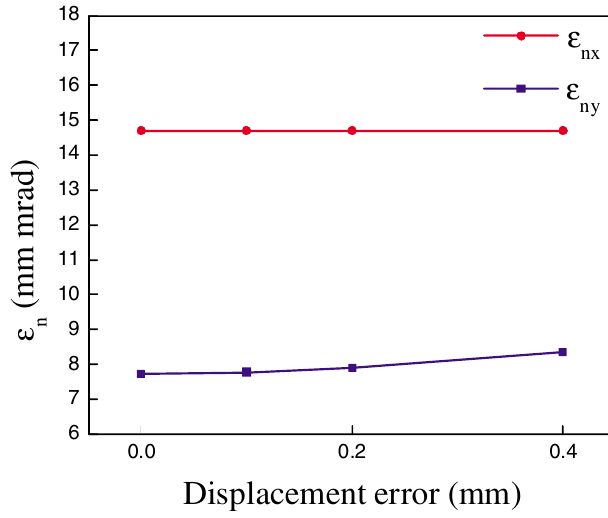
FIG. 9. (Color) Rotation error effect on normalized emittance growth through an otherwise ideal triplet, as simulated by ELEGANT